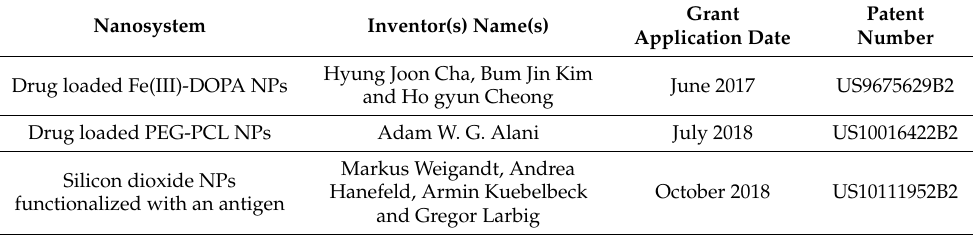
Table 7. Selected patented nanomedicine products with application to melanoma (not